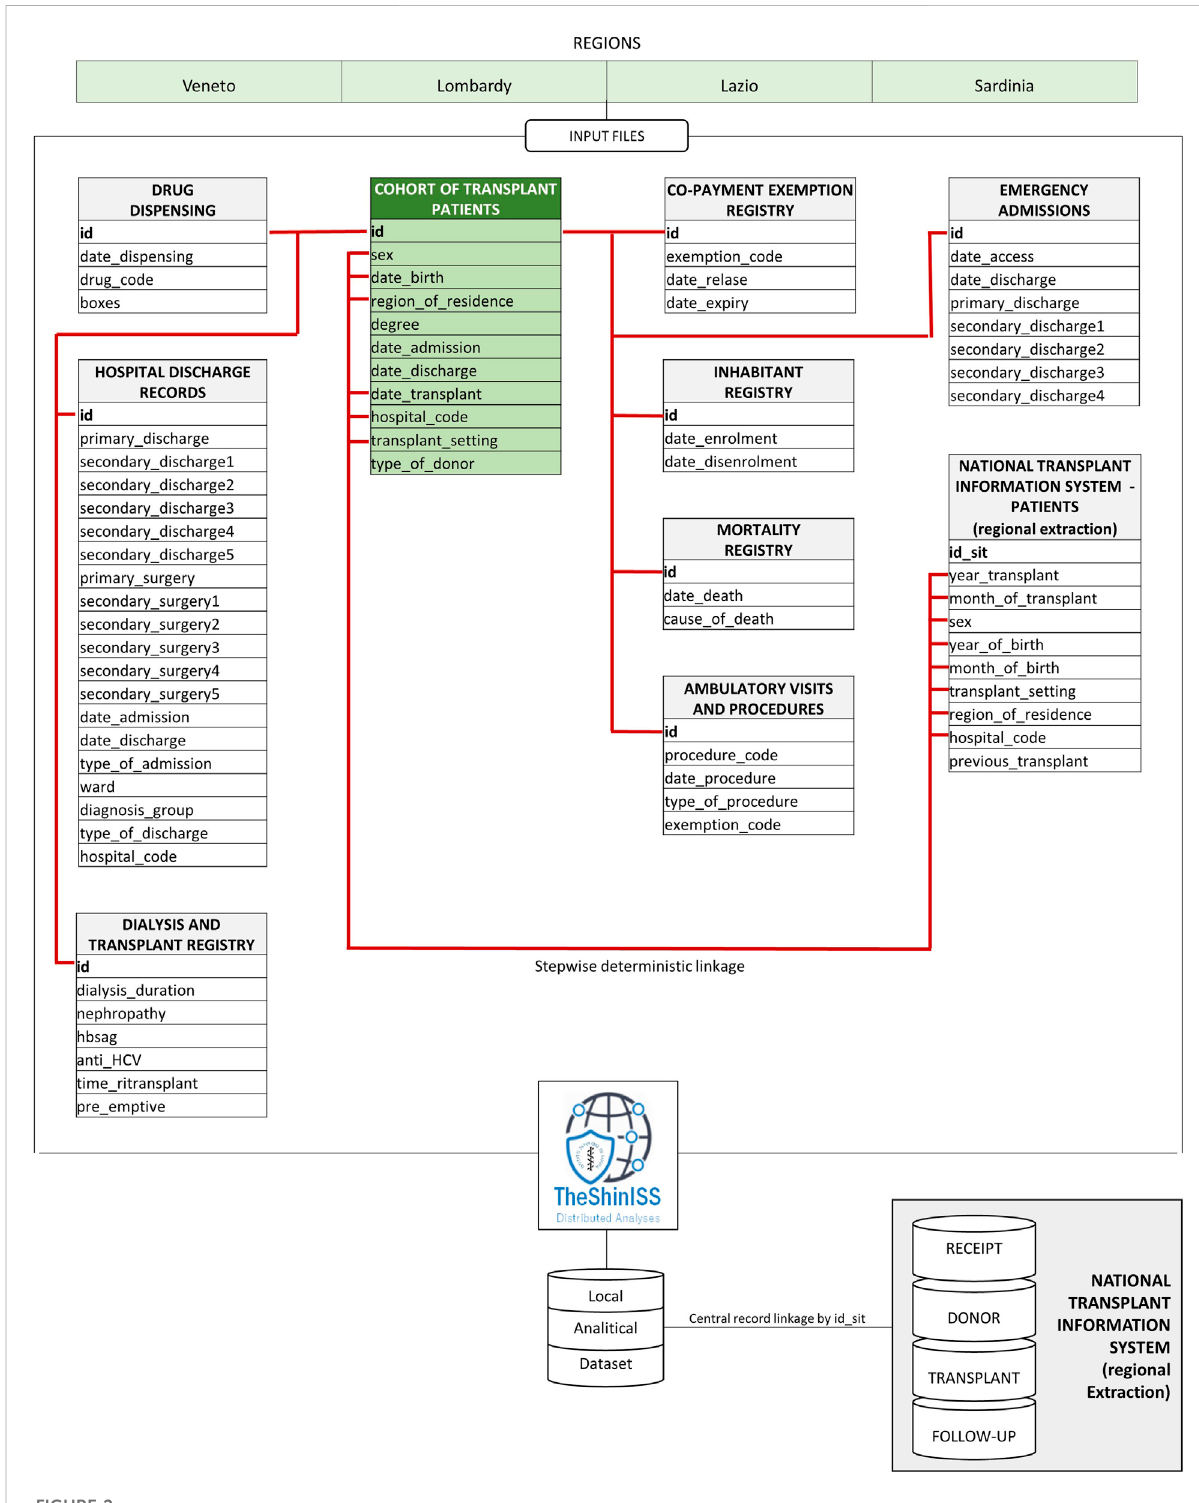
FIGURE 2 CESIT project distributed data research network using the common data